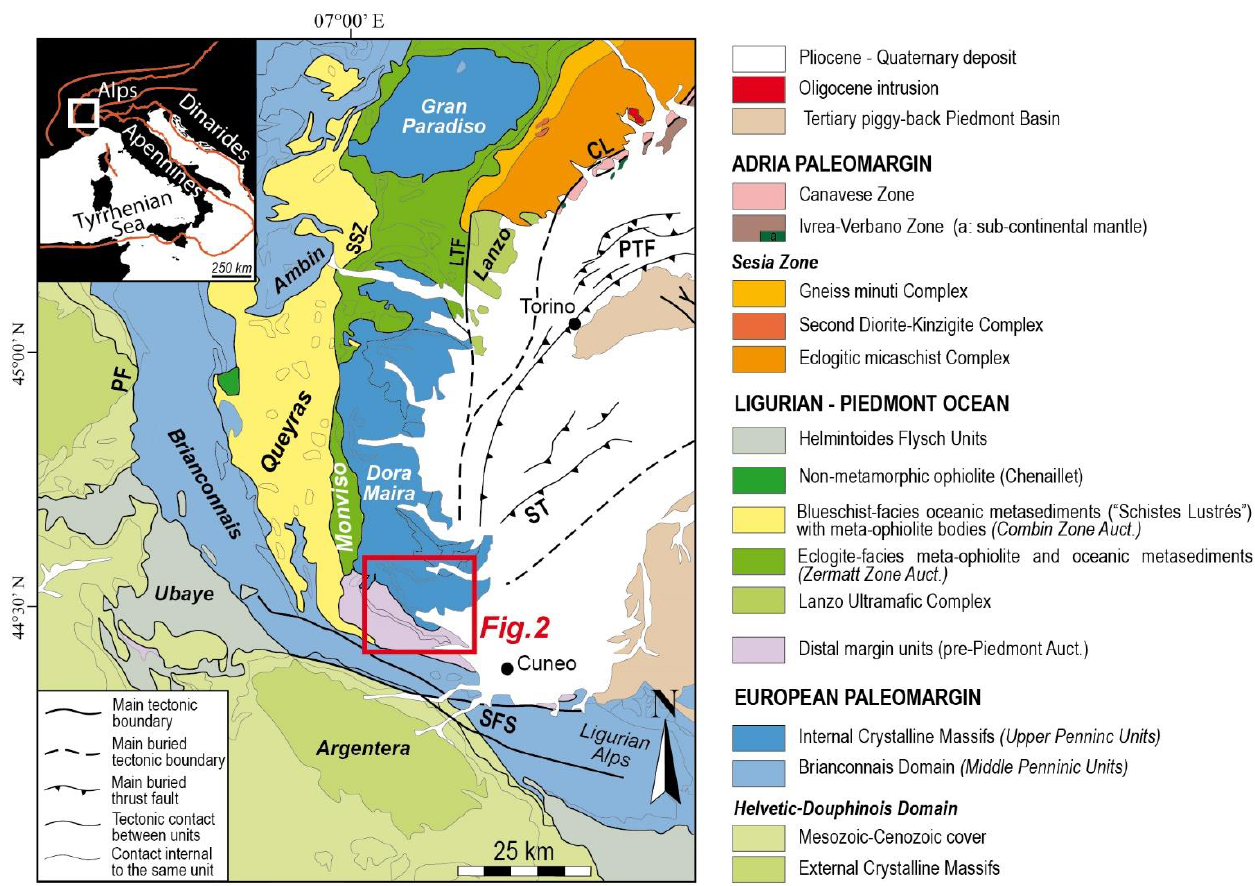
Figure 1. Simplified tectonic map of the Western Alps showing the location of the study area (red square). CL, Canavese Line; PF, Penninic Front; PTF, Padane Thrust Front; ST, Saluzzo Thrust; SFS, Stura Fault System; SSZ, Susa Shear Zone; LTF, Lis-Trana Fault.